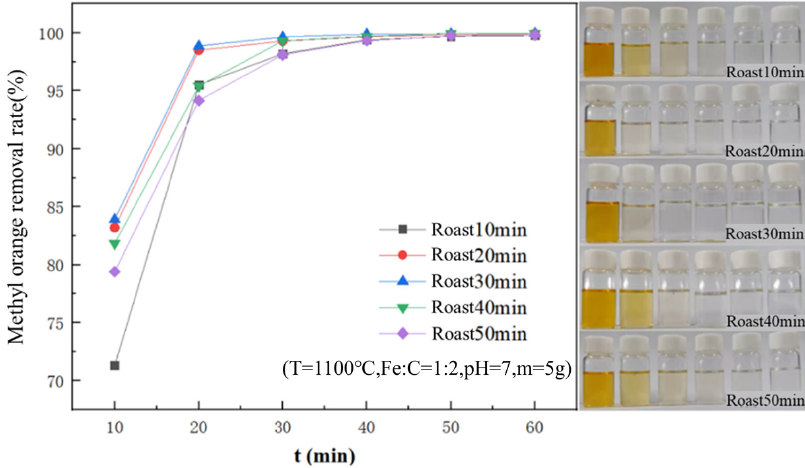
Figure 8. E ff ect of sintering time on removal of the fi ller methyl orange. Figure 8. Effect of sintering time on removal of the filler methyl